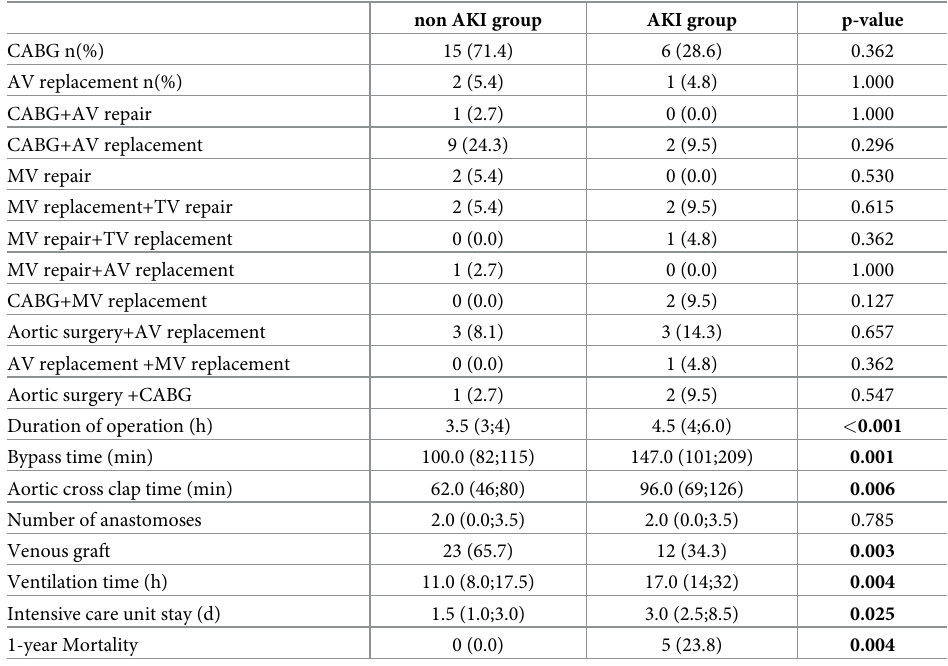
Table 2. Association of operative strategy for non-AKI group and AKI group.